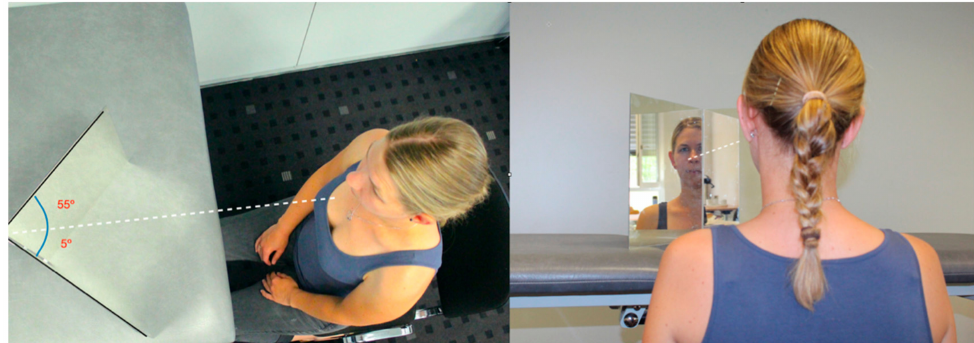
Figure 5. Visual mirror feedback by two mirrors of 30 cm by 30 cm with an angle of 100 degrees towards each other. The patient is facing the middle of the two mirrors whereby the right side of the face is projected on the left side when the right side is rotated for 55 degrees. For the left side, it is